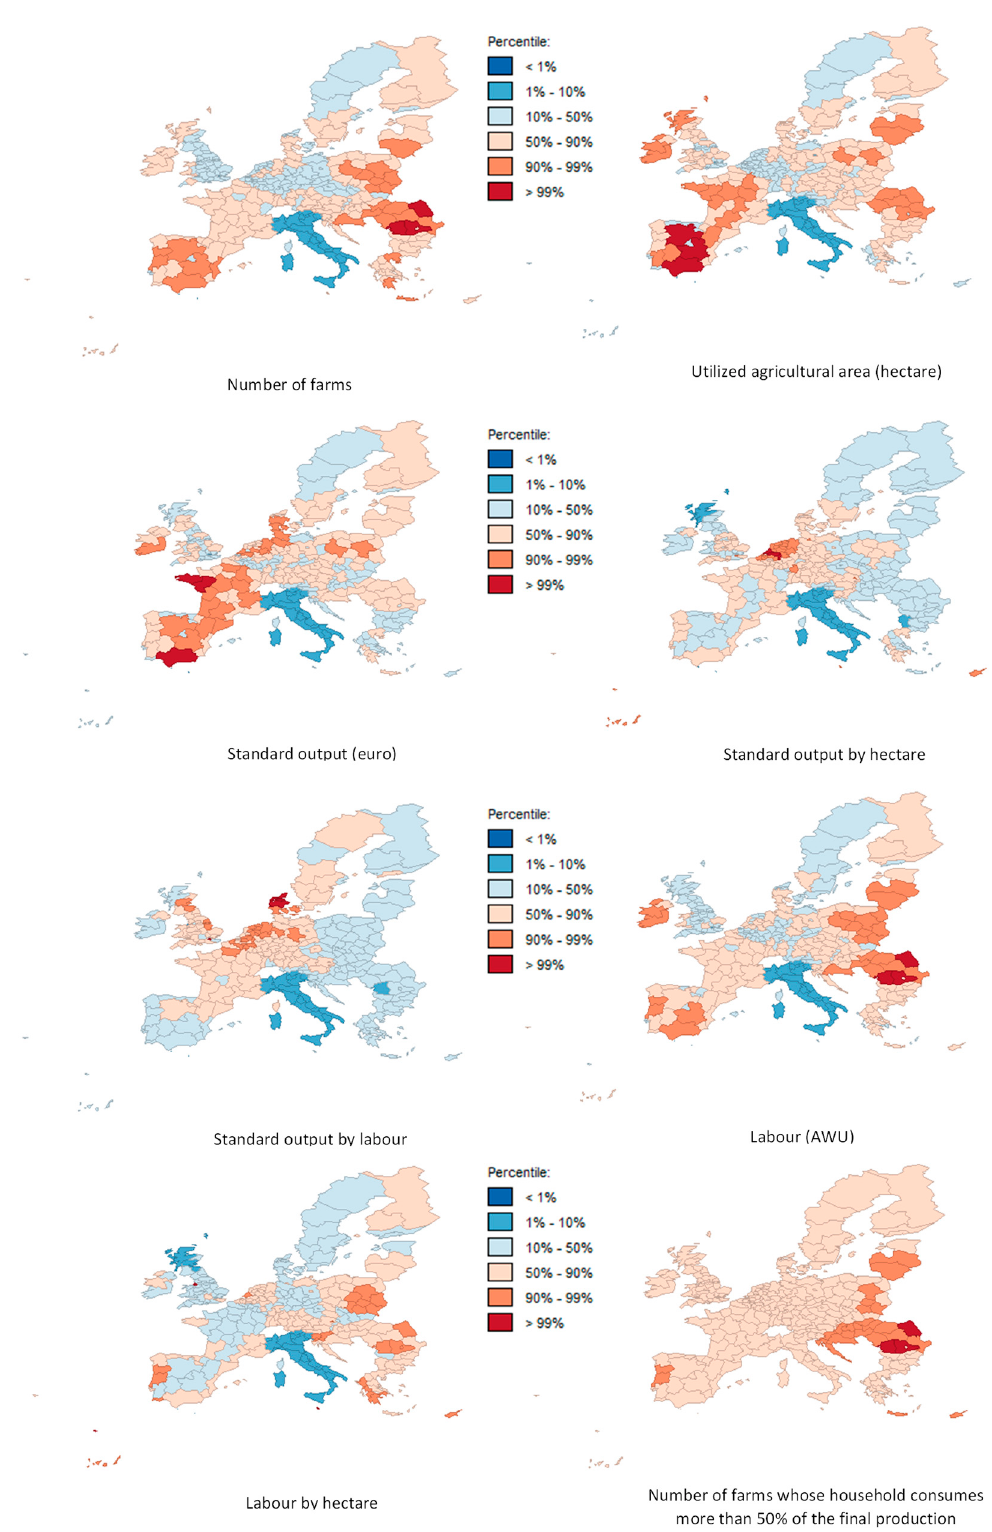
Figure 2. Some further variables associated with agricultural entrepreneurship in the EU.